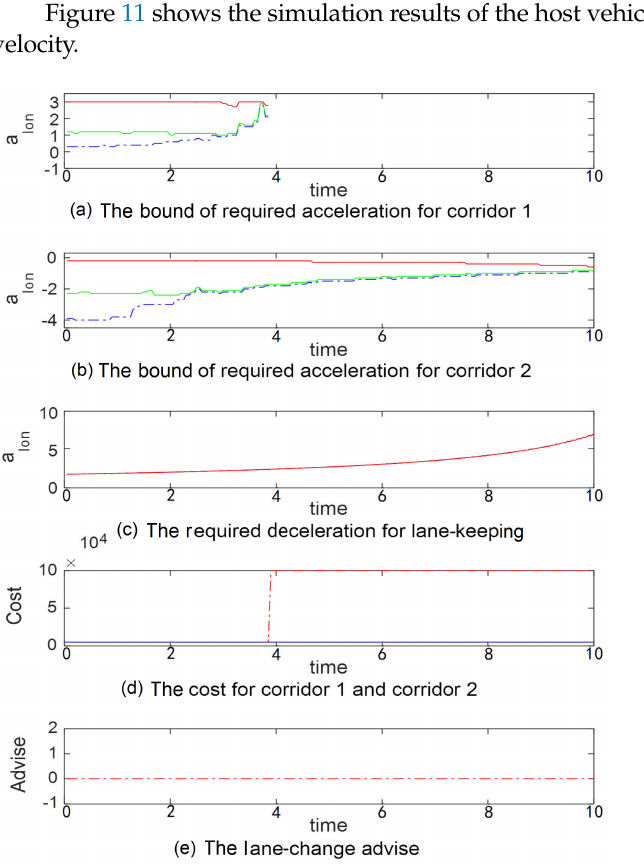
Figure 11. The maneuver evaluation result with a lon = 0.